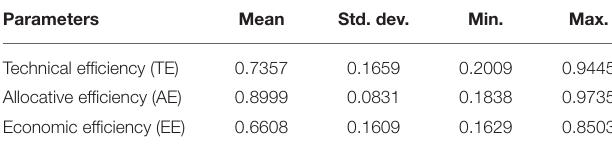
TABLE 7 | Summary statistics of efficiency